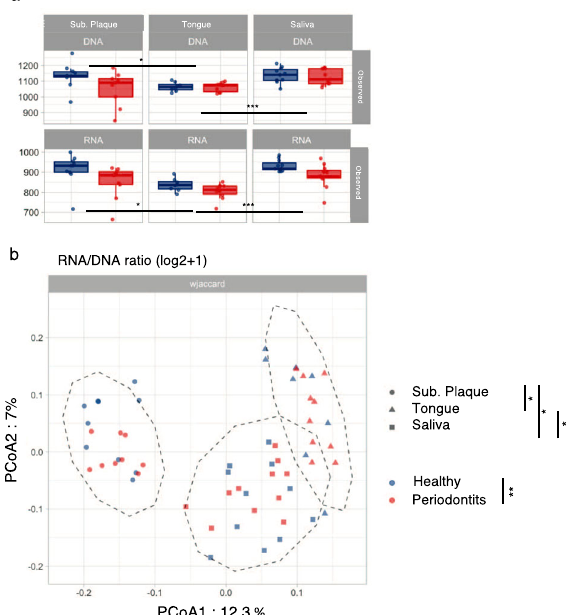
Fig. 4 Diversity of microbial genes associated with associated with EC numbers. a α -diversity of gene families found in metagenomes (DNA) and metatranscriptomes (RNA) in plaque, tongue bio fi lm, and saliva expressed as number of observed gene families (i.e., richness). Boxplots display fi rst quartile, median, and third quartile and whiskers represent 1.5 times the interquartile range from the fi rst and third quartiles. b β -diversity of gene expression visualized as measured by log RNA/DNA ratio quanti fi ed using weighted Jaccard distance and visualized on PCoA. Sample denotation: red: periodontitis, blue: oral health, circle: plaque, triangle: tongue bio fi lm, square: saliva. Signi fi cant differences were assessed using Kruskal – Wallis and PERMANOVAS tests for α and β -diversity, respectively. Signi fi cant FDR-adjusted p values were indicated as follows: *0.05 > p > 0.01 **0.01 > p > 0.001 *** p <